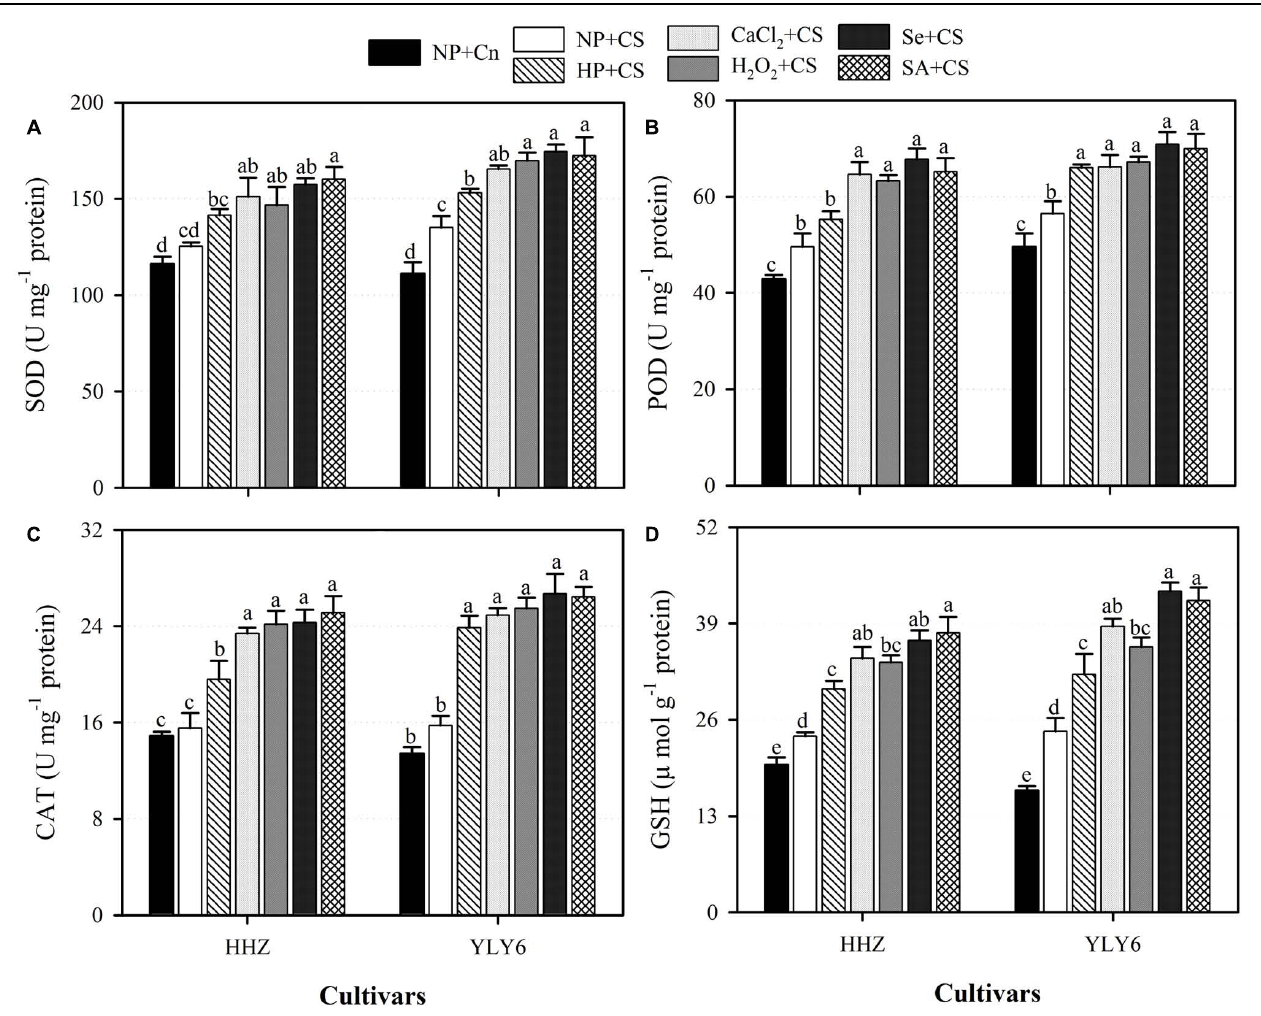
FIGURE 6 | Influence of various seed priming treatments on activities of enzymatic antioxidants, (A) SOD, (B) POD, (C) CAT, and (D) GSH content in rice seedlings under chilling stress. Vertical bars above mean indicate standard error of six replicates. Mean value for each treatment with different lowercase letters indicate significant differences by the LSD-test ( P < 0.05). NP + Cn: no priming and no stress, NP + CS: no priming and chilling stress, HP + CS: hydropriming and chilling stress, CaCl 2 + CS: calcium chloride priming and chilling stress, H 2 O 2 + CS: hydrogen peroxide priming and chilling stress. Se + CS: selenium priming and chilling stress, and SA + CS: salicylic acid priming and chilling stress, Cn: 28 ◦ C, CS: 18 ◦ C, HHZ: inbred cultivar huanghuazhan, YLY6: hybrid variety Yangliangyou-6. One unit (U) of SOD activity was defined as the amount of enzyme inhibiting the photochemical reduction of nitro blue tetrazolium chloride by 50% per minute at 560 nm. One unit of CAT was defined as the amount of enzyme required to oxidize 1 μ mol H 2 O 2 min − 1 . One unit of POD activity was defined as the amount of enzyme required to oxidize 1 μ mol guaiacol min − 1